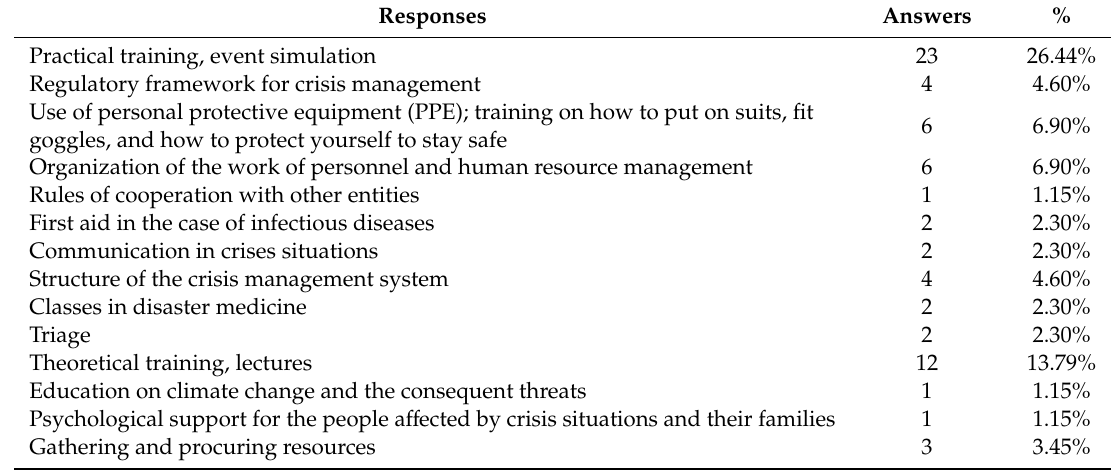
Table 3. Types of training that the respondents believed should be included in their study